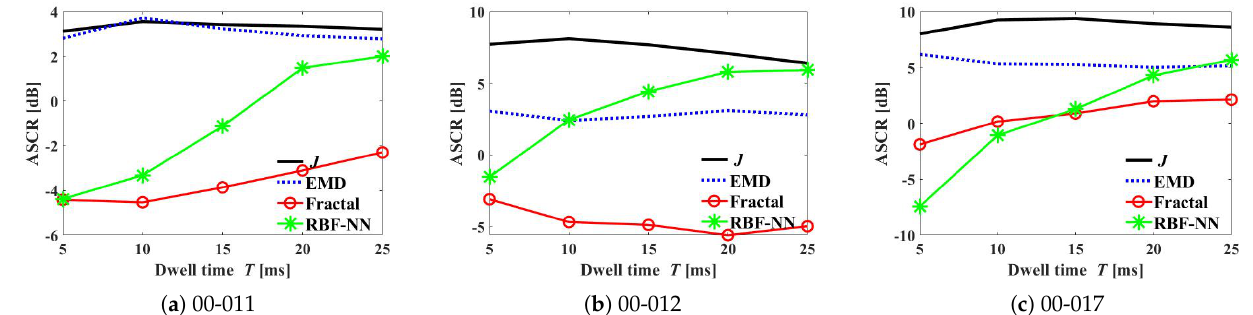
Figure 6. Mean value of average signal-to-clutter ratio (ASCR) versus T using each dataset.